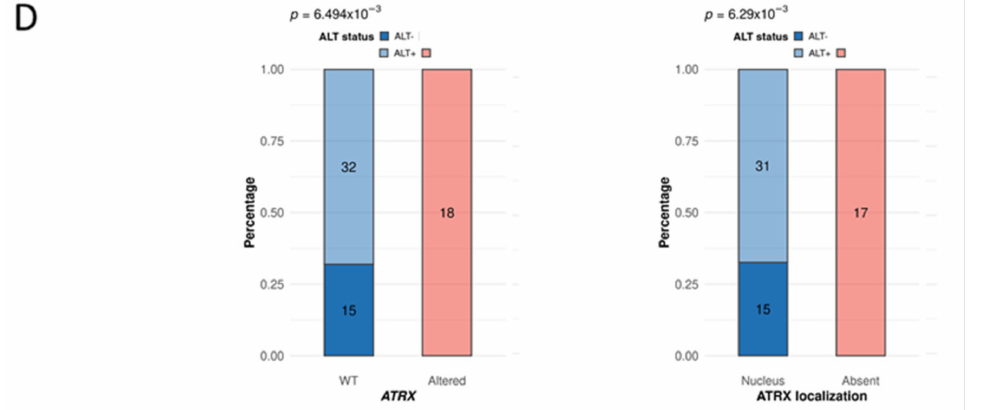
Figure 1. ATRX status and integrated representation in leiomyosarcomas. ( A ) ATRX alterations are color-coded according to their type (legend at the top). Numbers in bubbles represent tumor samples. Consequences of all point mutations on ATRX protein are annotated above a schematic representation of the protein, or below for two structural variants (LMS57 and LMS66). For the other three structural variants, annotations correspond to the break-point partner in genomic coordinates. ( B ) The integrated representation shows ATRX alterations, ATRX mRNA expression (by quartile), ATRX localization, ALT mechanism phenotype, tumor site, FNCLCC grade, presence or not of metastasis, and sex of each patient. Tumors are ordered by ATRX status, ALT phenotype, mRNA expression, and protein localization. ( C ) Association between ATRX alteration and its mRNA expression (log2 (FPKM + 1)) (left) or its protein localization (right). ( D ) Relation between ATRX status (left) or its protein localization (right) and ALT mechanism phenotype. For ATRX localization, the “absent” group means “not at the nucleus”, including all cases without expression and the case with a cytoplasmic localization (LMS16). p -values were calculated with Student test for ( C )—left and with Fisher test for ( C )—right and ( D